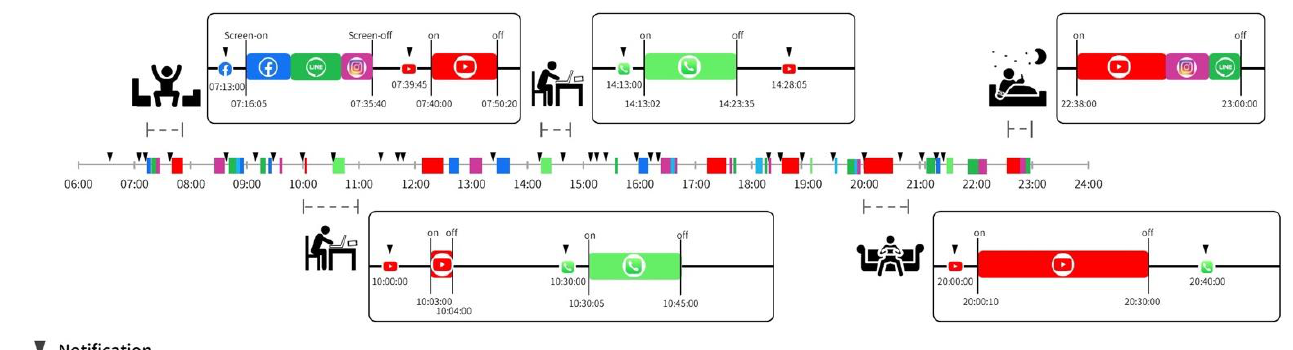
Figure 3. Apps designed to perform digital phenotyping automatically record smartphone events as three variables: (1) timestamps of screen-on/off, (2) type of apps used, and (3) notifications. The time between screen-on and successive screen-off is defined as one episode of use. The icons between screen-on and screen-off events represent the apps used during the episode. The information is processed by app algorithms to quantify the duration of app usage, the timestamps of notifications during and outside usage episodes, the reaction time from the moment a push notification is received to the start of app usage, and the reaction intensity, which is the duration of app usage following the notification. The digital lifeline illustrated in this figure spans from 6:00 in the morning to midnight; it specifically highlights the user’s contrasting usage behaviors during work and off-work hours.